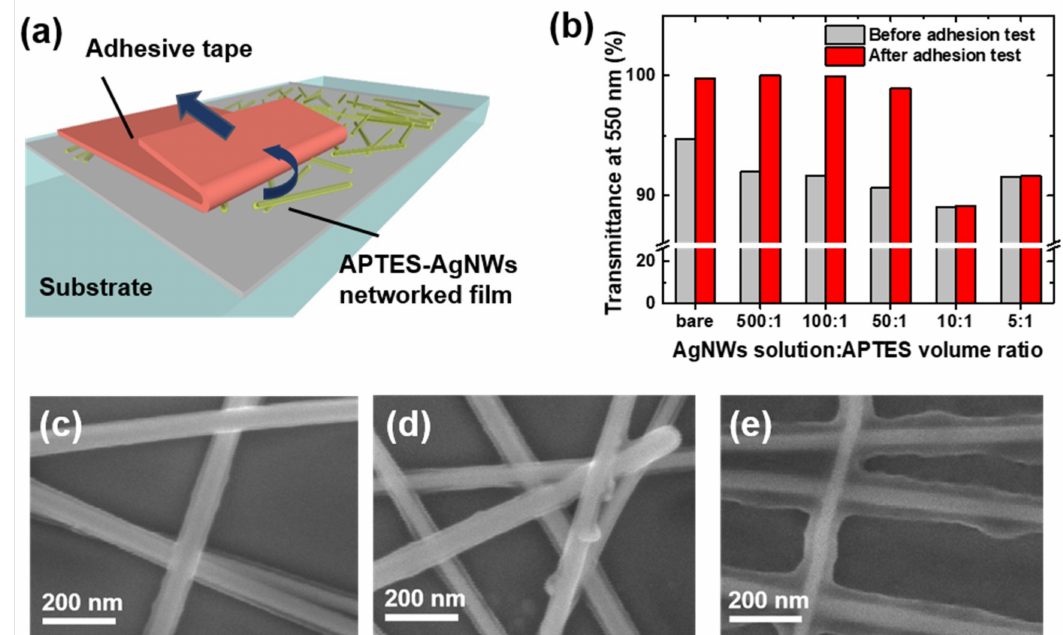
Figure 4. ( a ) Schematic illustration of the adhesion test for the APTES-AgNWs networked film. ( b ) Transmittance at λ = 550 nm of the APTES-AgNWs networked films on the glass substrate. The APTES-AgNWs were prepared by mixing 0.5 wt.% of the AgNW solution with APTES at the volume ratios of 500:1, 100:1, 50:1, 10:1, and 5:1. The APTES-AgNWs networked films were deposited directly on a glass substrate with DN = 3 and NC = 1. SEM images of the APTES-AgNWs with the AgNWs solution:APTES volume ratios of ( c ) 10:1, ( d ) 100:1, ( e )